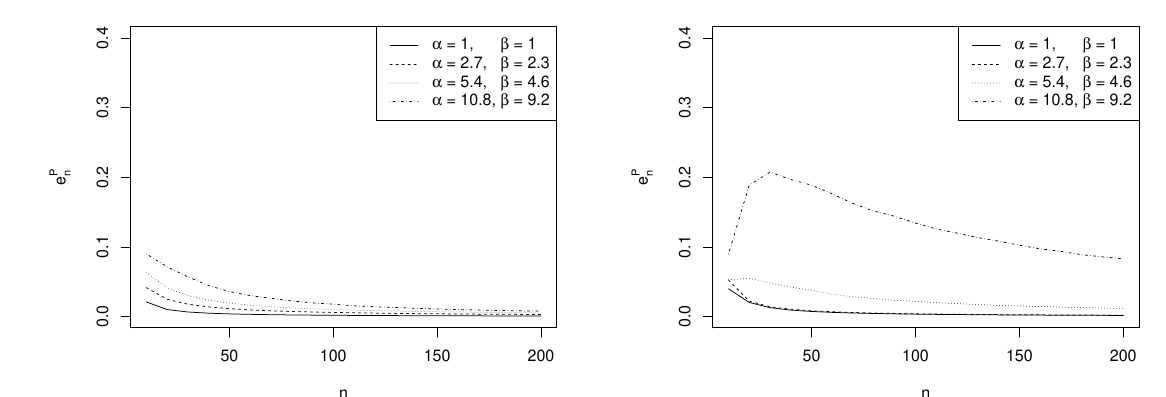
Figure 3. Plots of e P n as a function of n for several values of the prior hyperparameters ( α , β ) with θ d = 0.45 ( left panel ) and θ d = 0.8 ( right panel ), when the logodds ψ is the parameter of